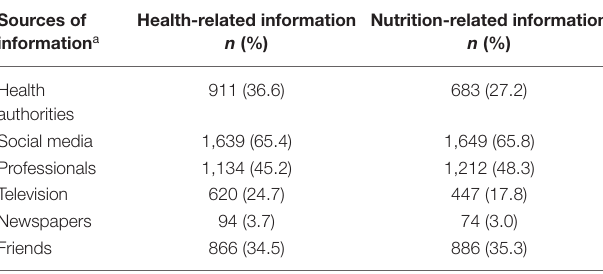
TABLE 3 | Eating habits pre-and during COVID-19 pandemic ( n = 2,507).